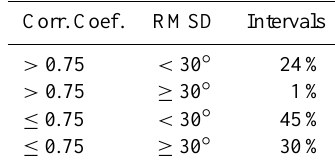
Table A1. Results of clock angle correlation procedure. Corr. Coef.